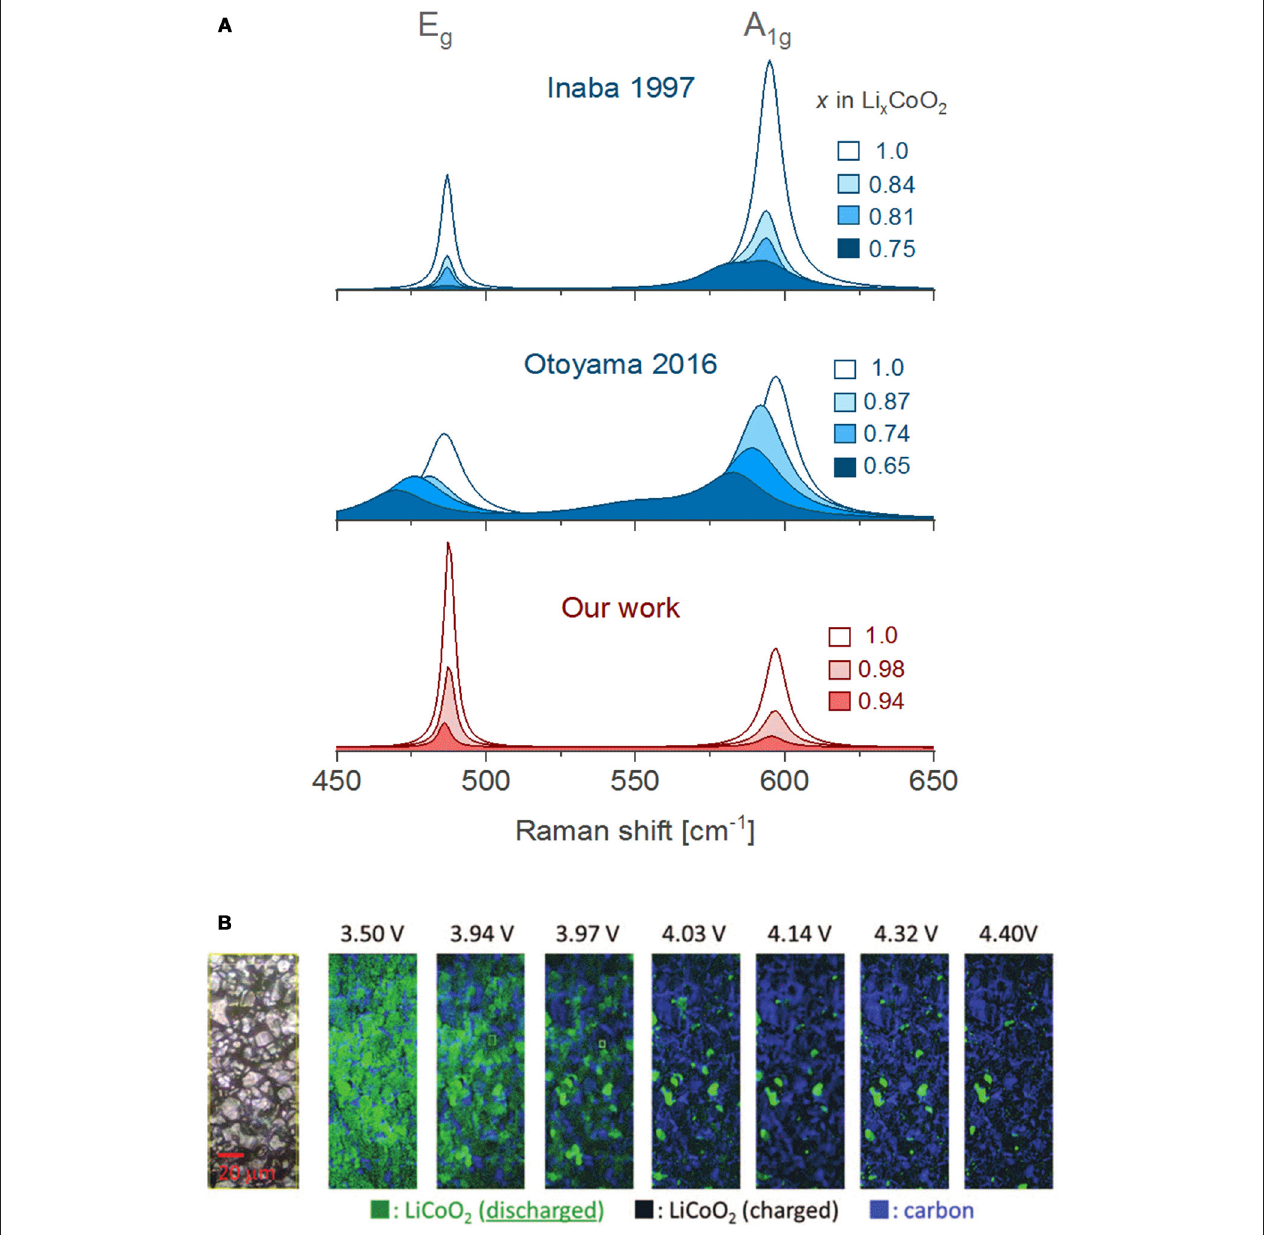
FIGURE 5 | (A) Comparison of in situ / operando Raman spectra obtained by Inaba et al. using a PC based liquid electrolyte (Inaba et al., 1997), Otoyama et al. in an all-solid-state cell (Otoyama et al., 2016a) and our results using an EC/DMC based liquid electrolyte. (B) In situ Raman mapping of a composite LiCoO 2 electrode during the first charge (reprinted from reference Nishi et al., 2013 with minor editions, with permission of the Electrochemical Society). All spectra were here adapted for clarity of